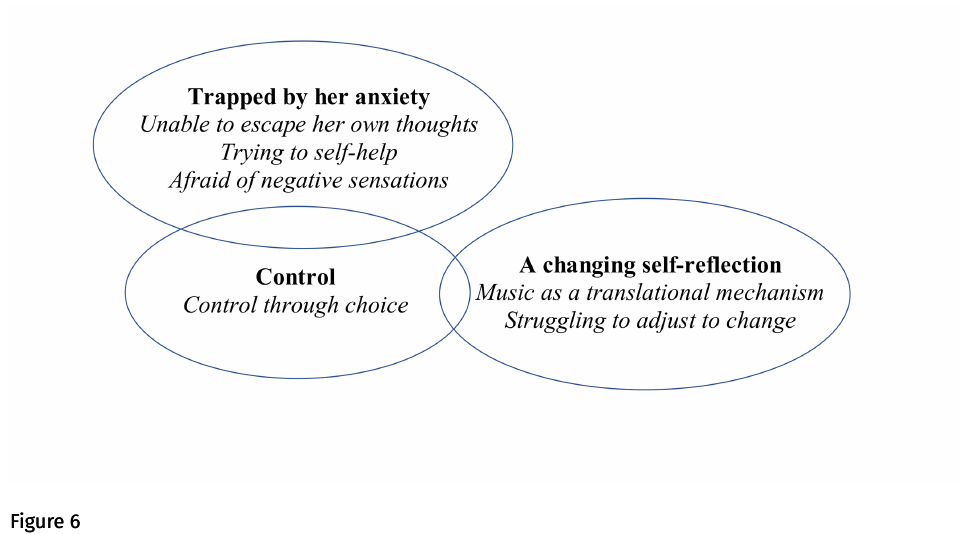
Interrelationships of the three superordinate